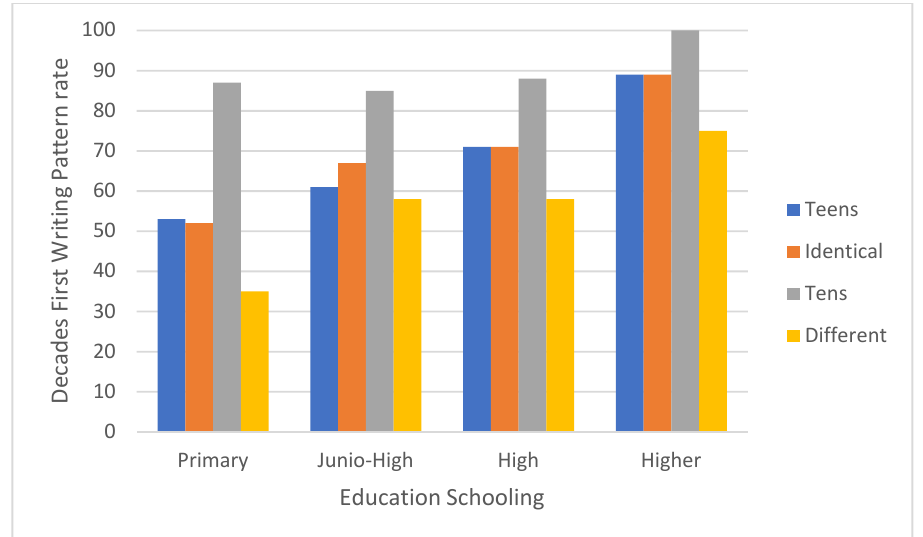
Figure 3. The units first (right to left) writing pattern rates as a function of two-digit numbers cate- gory (teens, identical, tens and different) and educational level (primary, junior-high, high, higher).